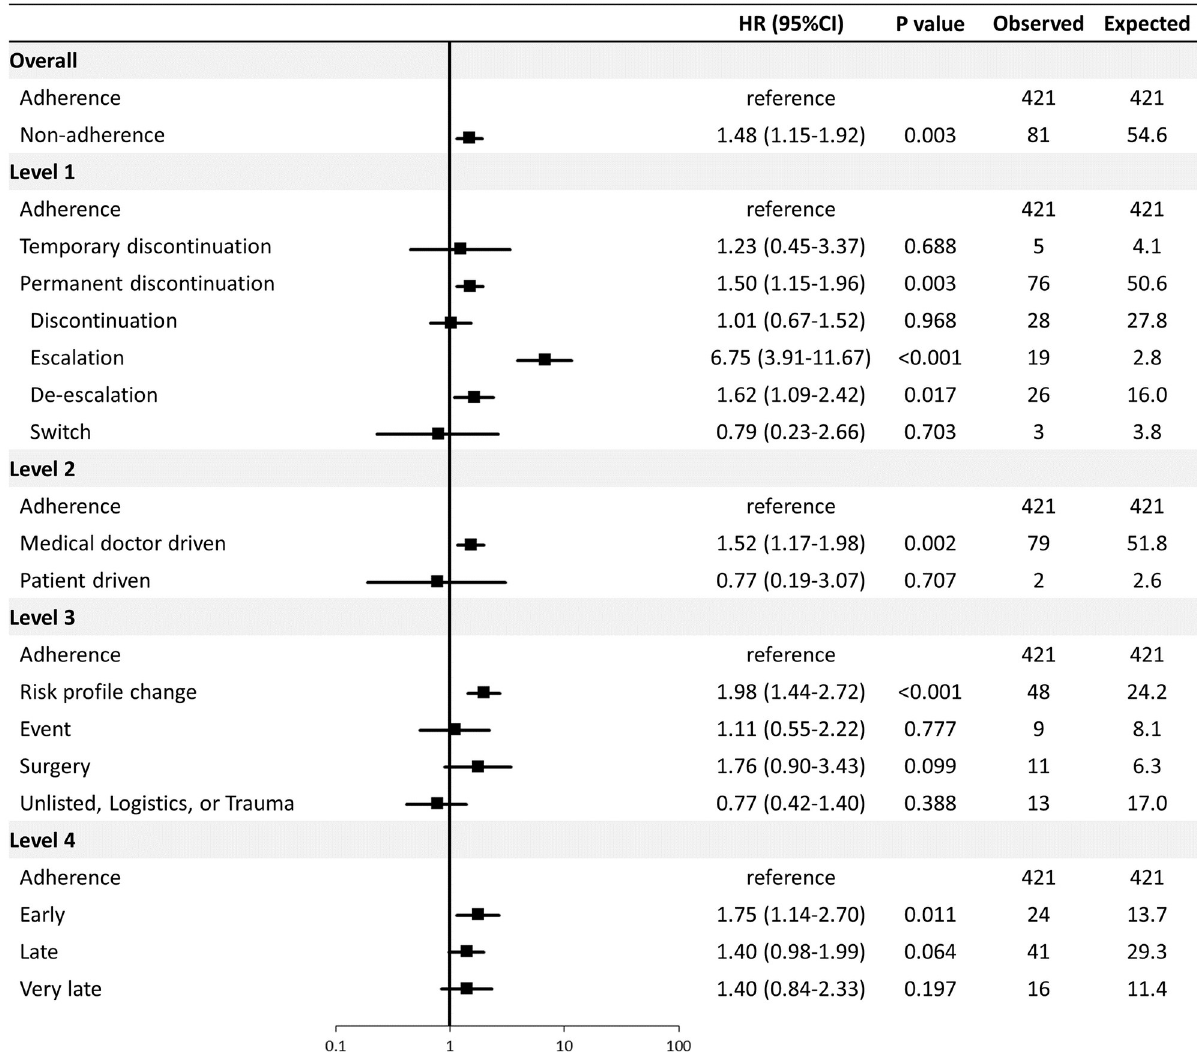
Fig 4. Multivariable Cox analysis for POCE at 1 year according to non-adherence levels. Of the study patients, 90.4% (3525 of 3896 patients) were included in the multivariable models. The following covariates were entered in the models: age, female sex, diabetes mellitus, eGFR, peripheral artery disease, myocardial infarction at presentation, cardiogenic shock, chronic obstructive lung disease, history of cancer, history of PCI, and use of new generation DES. CI = confidence interval, DAPT = dual antiplatelet therapy, DES = drug eluting stent, eGFR = estimated glomerular filtration rate, HR = hazard ratio, PCI = percutaneous coronary